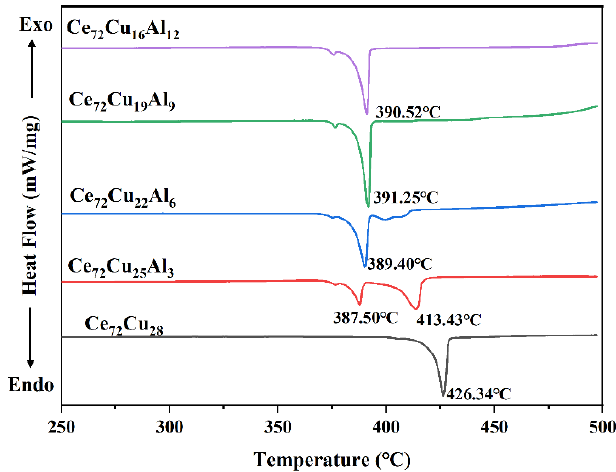
Figure 3. DSC curves of Ce 72 Cu 28-x Al x alloys with different Al contents. The alloy binder is mostly located at the grain boundaries of the magnet and the magnetic performances of the grain boundary phase influence the final properties of the magnet. Thus, the magnetic performances of Ce 72 Cu 28-x Al x alloy powders were also tested by vibrating the sample magnetometer, and its VSM and local amplification diagrams are shown in Figure 4. Both Ce-Cu binary alloy and Ce-Cu-Al ternary alloys demonstrate weak magnetic characteristics and the magnetic performances of the alloys change with the increase in Al content. When the atomic percentage of Al increases from x = 0 at.% to x = 9 at.%, the remanence of the alloys gradually increases from 0.53 emu/g to 3.01 emu/g. Then, when it increases to 12 at.%, the remanence of the Ce 72 Cu 16 Al 12 alloy decreases sharply, even lower than that of Ce 72 Cu 28 alloy. Coercivity also shows a similar variation trend. After adding Al, the coercivity of the powders rapidly increases from 1304.57Oe at x = 0 at.% to more than 6000 Oe and reaches 7059.16 Oe at x= 3 at.%. However, when Al content increases to 12 at.%, the coercivity of the Ce 72 Cu 16 Al 12 alloy decreases rapidly to several hundred Oe. These results suggest that the Ce-Cu binary alloy exhibits weak magnetic properties, and the addition of Al demonstrates a positive effect on its magnetic performance; therefore, the coercivity of Ce-Cu-Al alloy powders greatly increases while the remanence is also improved. However, when the Al content is too high, the remanence and coercivity will drop sharply.